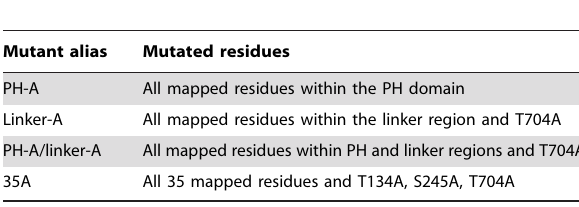
Table 2. Mutation of remaining sites, including non- consensus